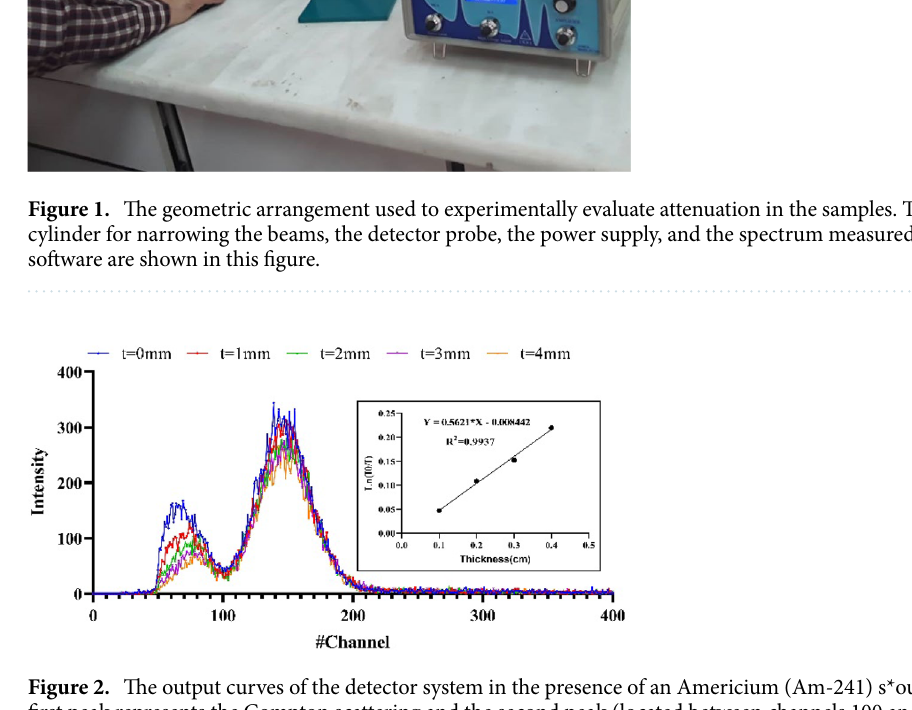
Figure 2. The output curves of the detector system in the presence of an Americium (Am-241) s*ource. The first peak represents the Compton scattering and the second peak (located between channels 100 and 200) displays the main curve for measuring the radiation intensity. The diagram shows how linear regression was used to calculate the linear attenuation